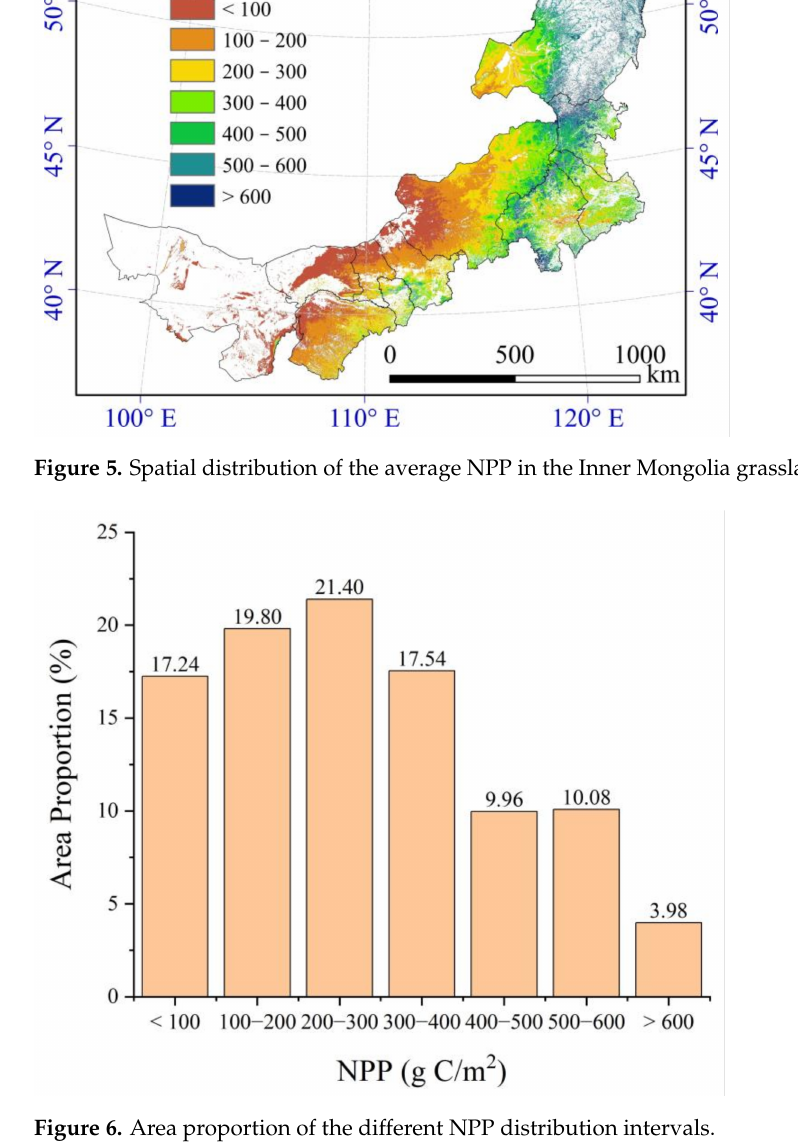
Figure 6. Area proportion of the different NPP distribution